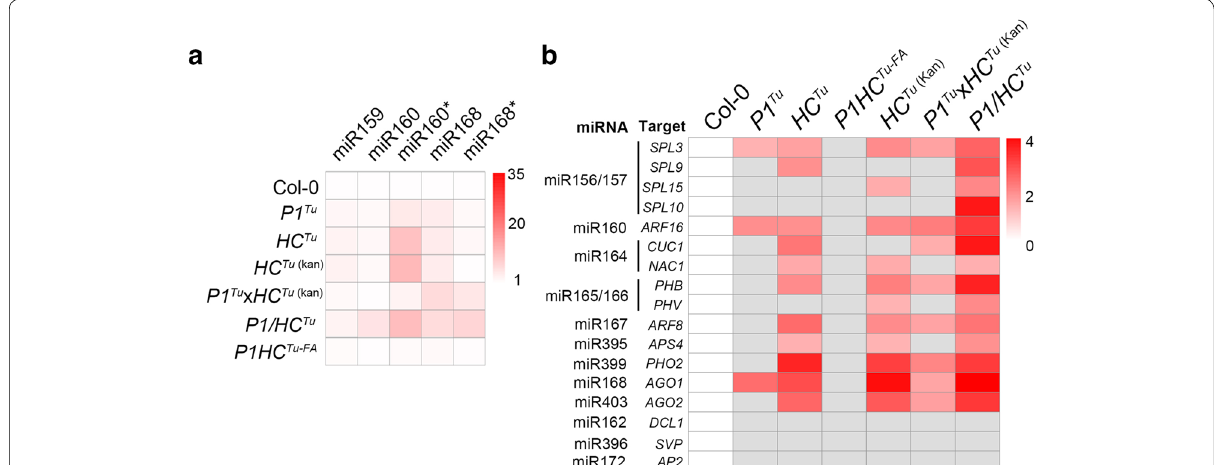
Fig. 3 Abnormal accumulation of miRNA/miRNA*s and target mRNAs. a Heatmaps of miRNA and miRNA* and b miRNA target gene expression in various transgenic plants. The values of heatmap for miRNA were convert from miRNA northern blot. The values of heatmap for target RNAs were convert from transcriptome profiles. Significant upregulation (Student’s t test; P value < 0.05) is labeled in red. Gray indicates differential expression that is not significant. The values on the right indicate the results of the log2 (each sample/Col‑0)